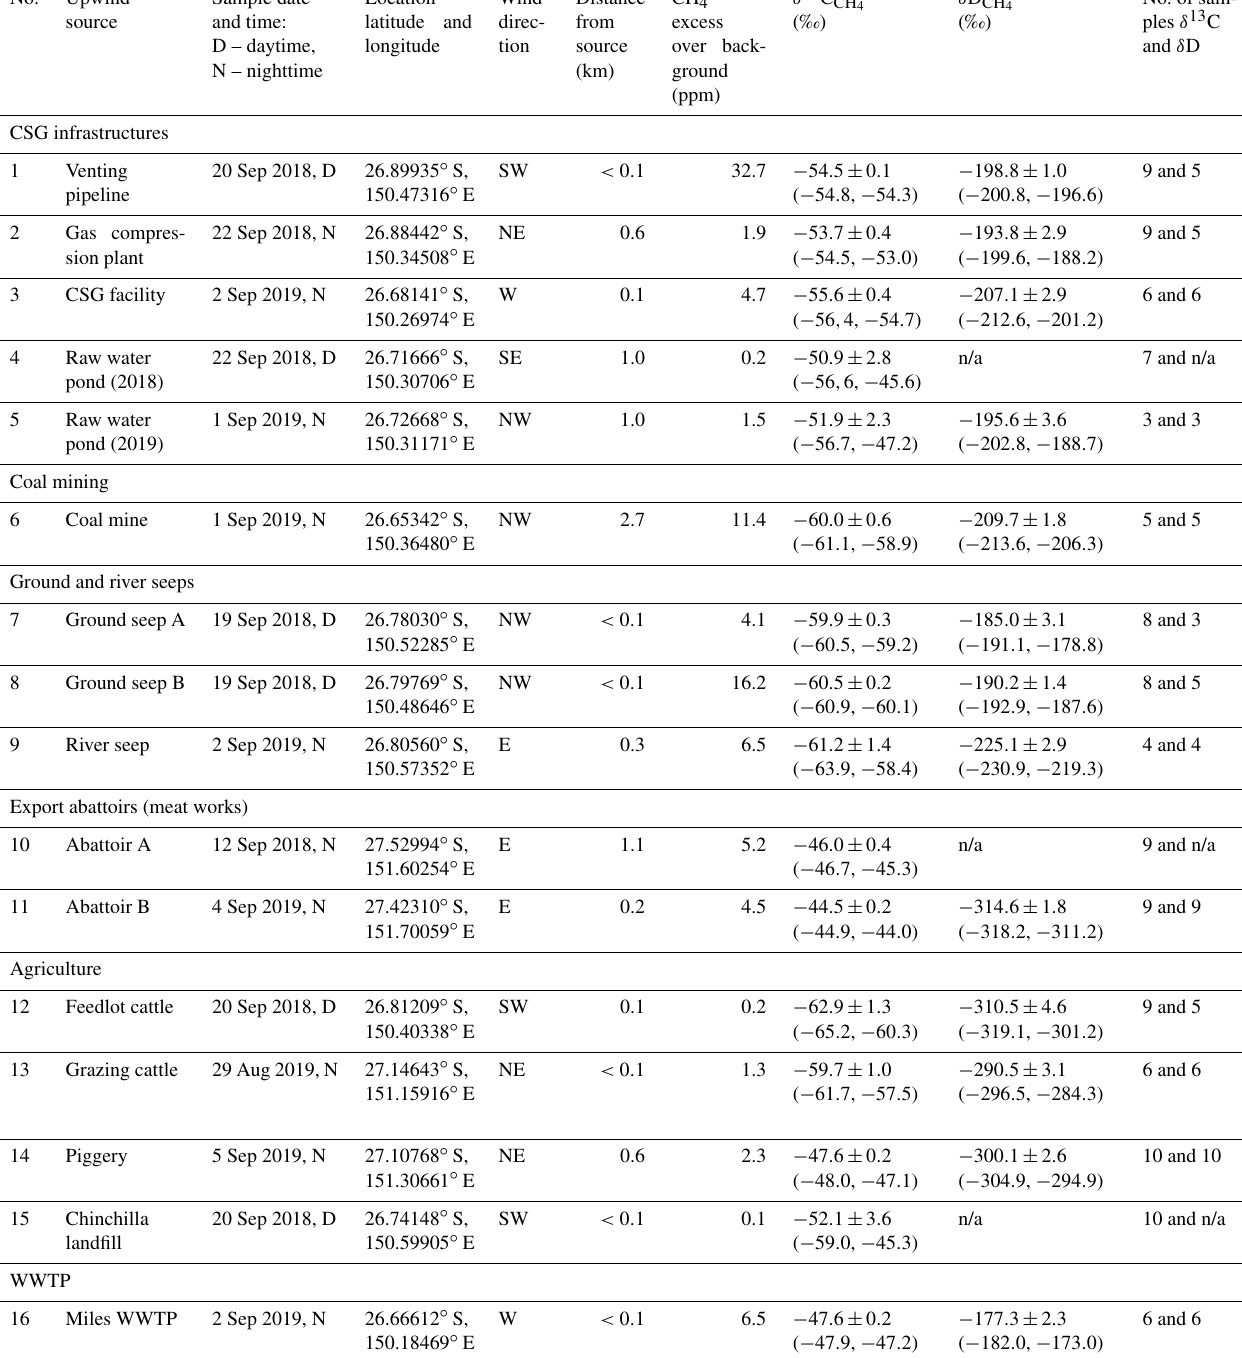
Table 2. CH 4 source signature results for plumes sampled in the Surat Basin 2018 and 2019 campaigns. CH 4 excess over background (ppm) for the samples that were used to calculate the source signature are presented, and δ 13 C CH Bayesian posterior distribution mean, standard deviation, and 95% credible interval (in brackets). n/a: not